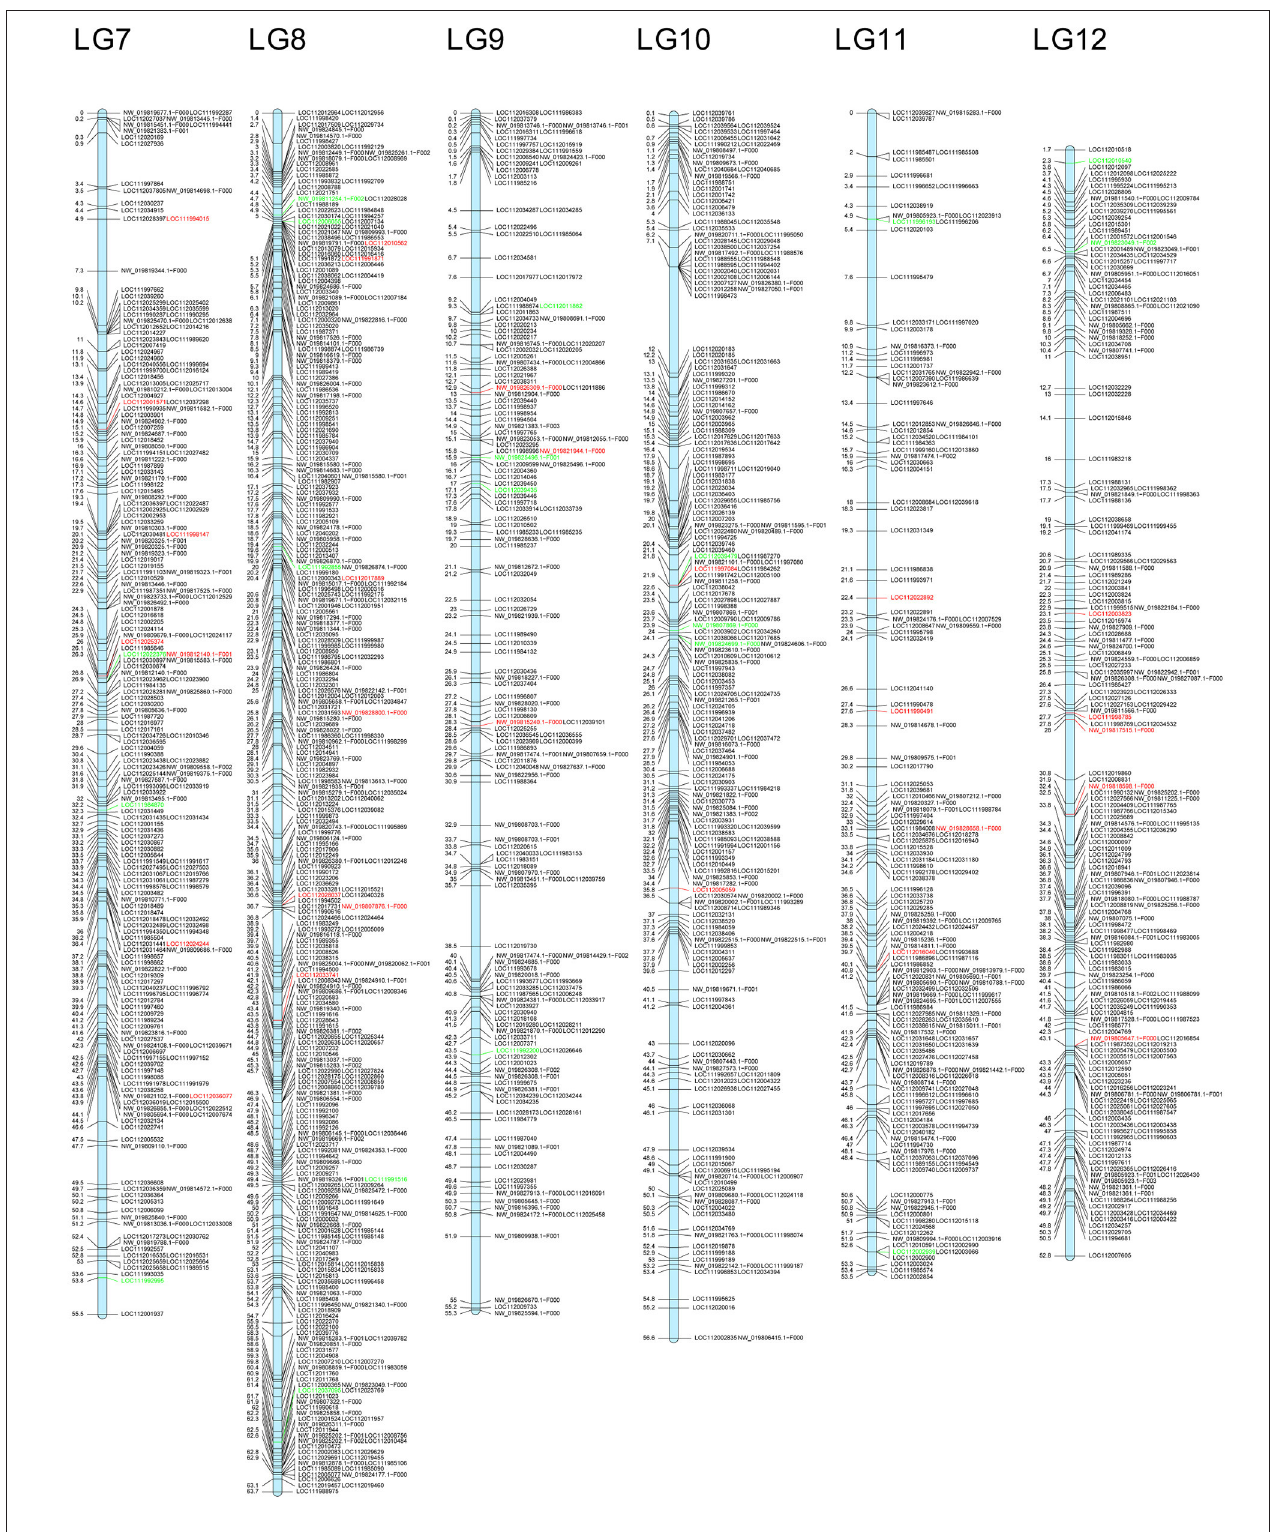
FIGURE 5 | Putative location in the Q. robur linkage groups of the genomic fragments including markers from ScnI. Location of markers with allelic frequencies in the adult hybrids very similar to one of the parental species is highlighted in red ( Q. ilex ) or in green ( Q. suber ).